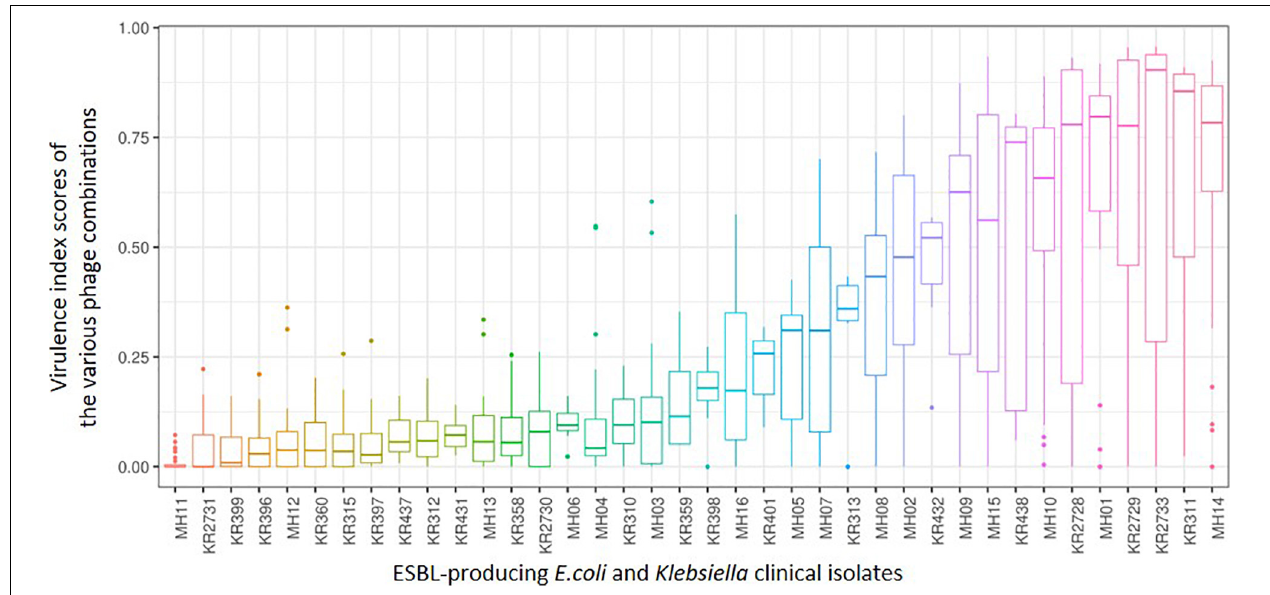
FIGURE 5 | A box and whisker plot depicting the range of killing assay virulence index scores from all phage combinations explored during this work for each of the 38 ESBL-producing clinical isolates. From left to right shows the ESBL-producing clinical isolates that are most resistant to the combinations attempted to those that are most sensitive. Please note not all combinations were completed in triplicate for those combinations that were not part of the final ESBL cocktail (all six